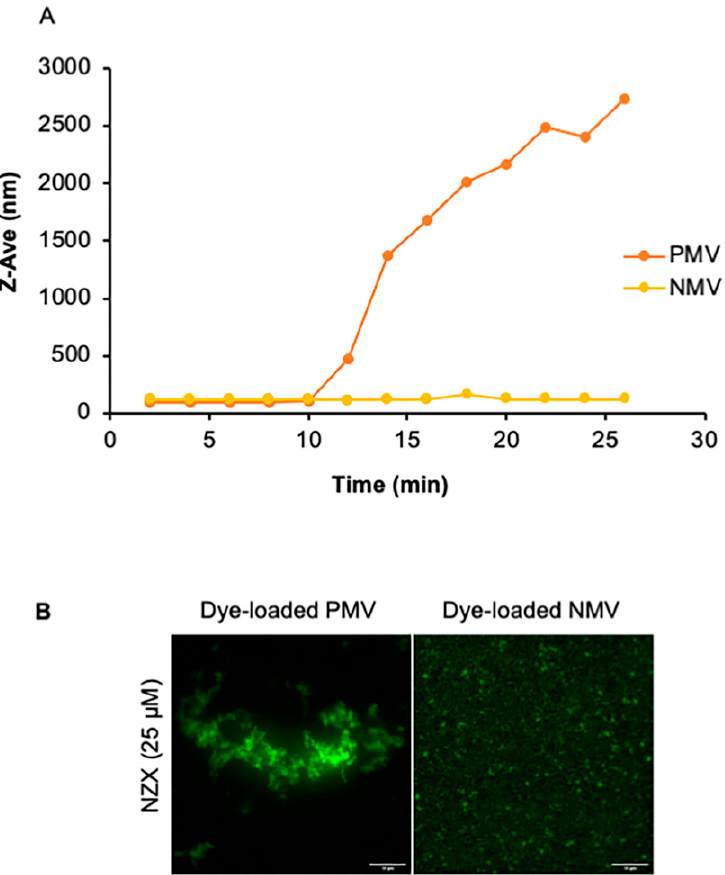
Figure 4. Aggregative properties of the peptide. ( A ) DLS size profiles of the LUV when incubated with NZX. Data show kinetic measurement over thirty minutes in the presence and absence of NZX.